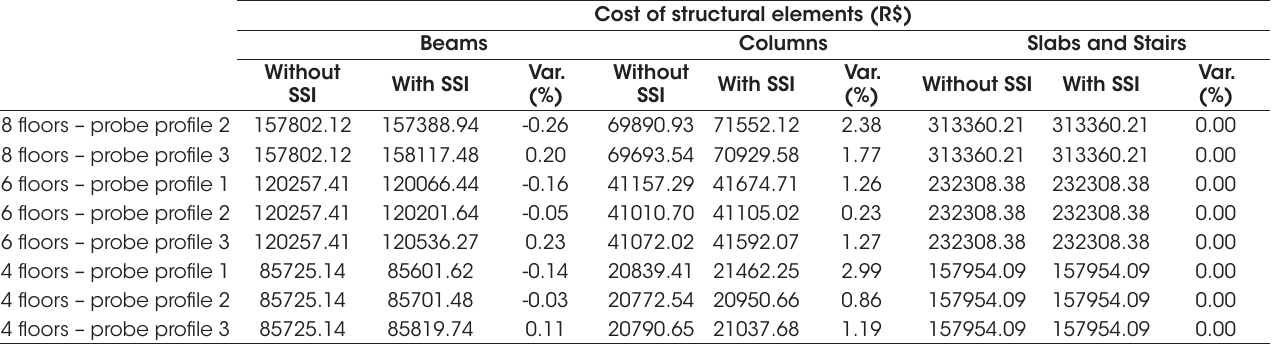
Cost of the superstructure's structural elements and their respective variations Cost of structural elements